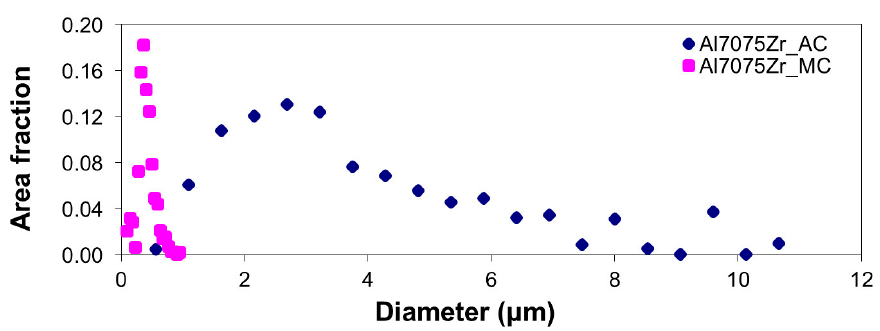
Figure 13. Grain size distribution of SPS compacts.